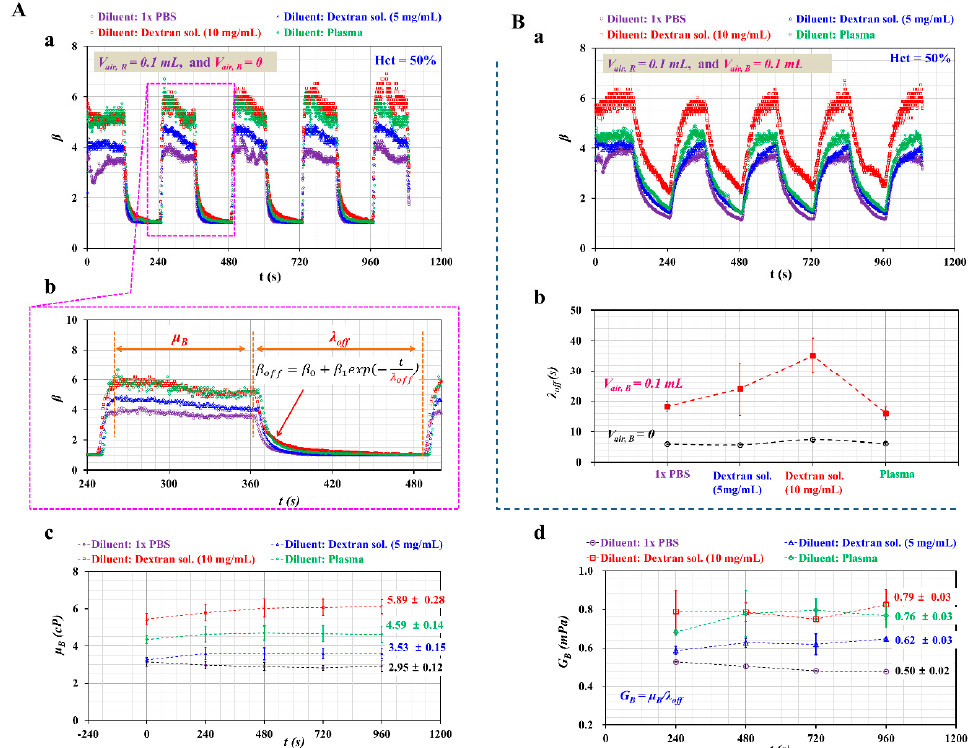
Figure 7. Quantitative evaluations of viscosity ( μ B ) and time constant ( λ off ) with respect to diluent and air cavity in the blood syringe. Here, the flow rate of the individual syringe pump and the air cavity in the reference fluid syringe were fixed at Q 0 = 0.5 mL/h and V air, R = 0.1 mL, respectively. ( A ) Variations of viscosity ( μ B ) and elasticity ( G B ) with respect to diluent and V air, B = 0. (a) Temporal variations of β with respect to diluent and V air, B = 0. (b) Quantification of μ B and λ off during a single period. Here, μ B and λ off were obtained sequentially by turning on and off the syringe pump. (c) Variations of μ B at intervals of 240 s. (d) Variations of G B with respect to diluent. Here, G B was obtained by dividing μ B by λ off . ( B ) Variations of λ off with respect to diluent and V air, B = 0.1 mL. (a) Temporal variations of β with respect to diluent. (b) Variations of λ off with respect to diluent and V air, B .